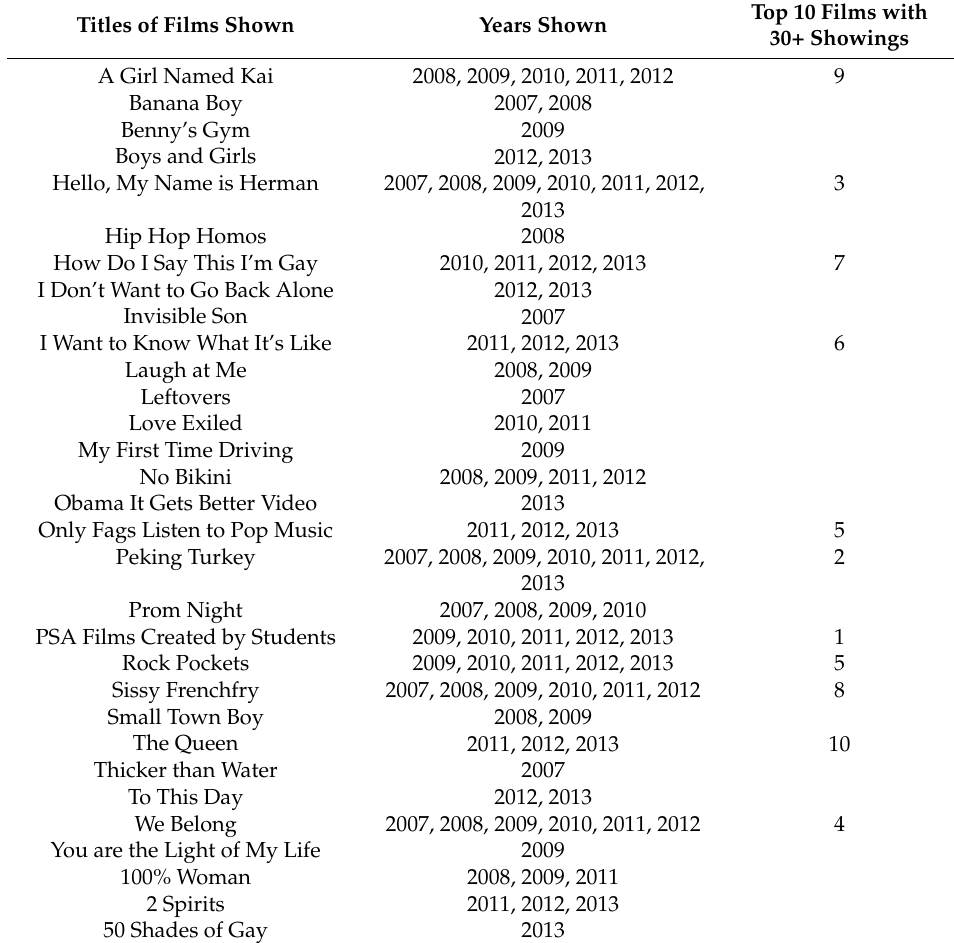
Table 1. Films shown by Out in Schools in their events during 2007 through 2013 *. Titles of Films Shown Years Shown